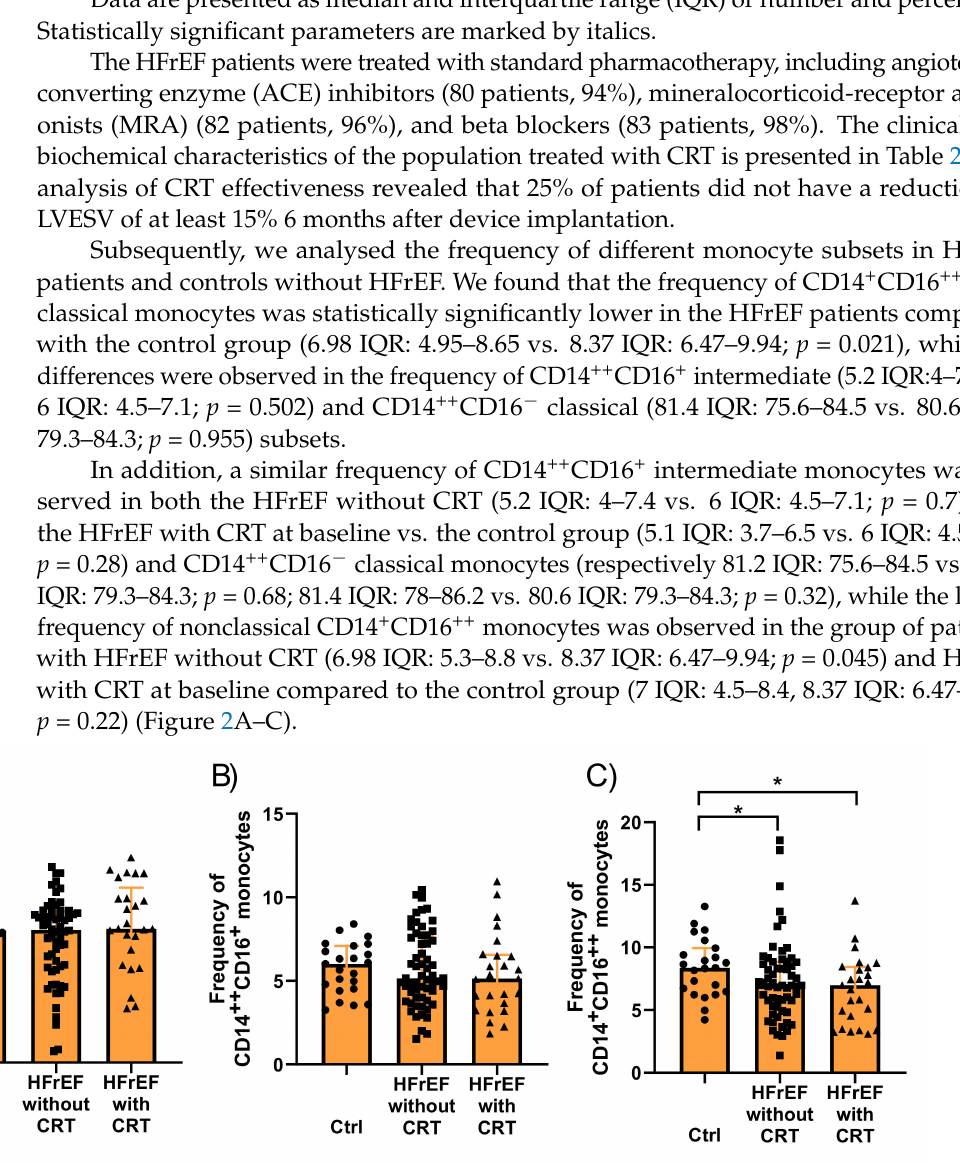
Figure 2. Monocyte subsets in control (Ctrl), patients with heart failure with reduced ejection fraction, who were not qualified for cardiac resynchronization therapy (HFrEF without CRT), and HFrEF patients qualified for cardiac resynchronization therapy (HFrEF with CRT) at baseline. Frequency of ( A ) classical (CD14 ++ CD16 − ) ( B ) intermediate (CD14 ++ 16 + ), and ( C ) nonclassical (CD14 + 16 ++ ) monocytes. * p <